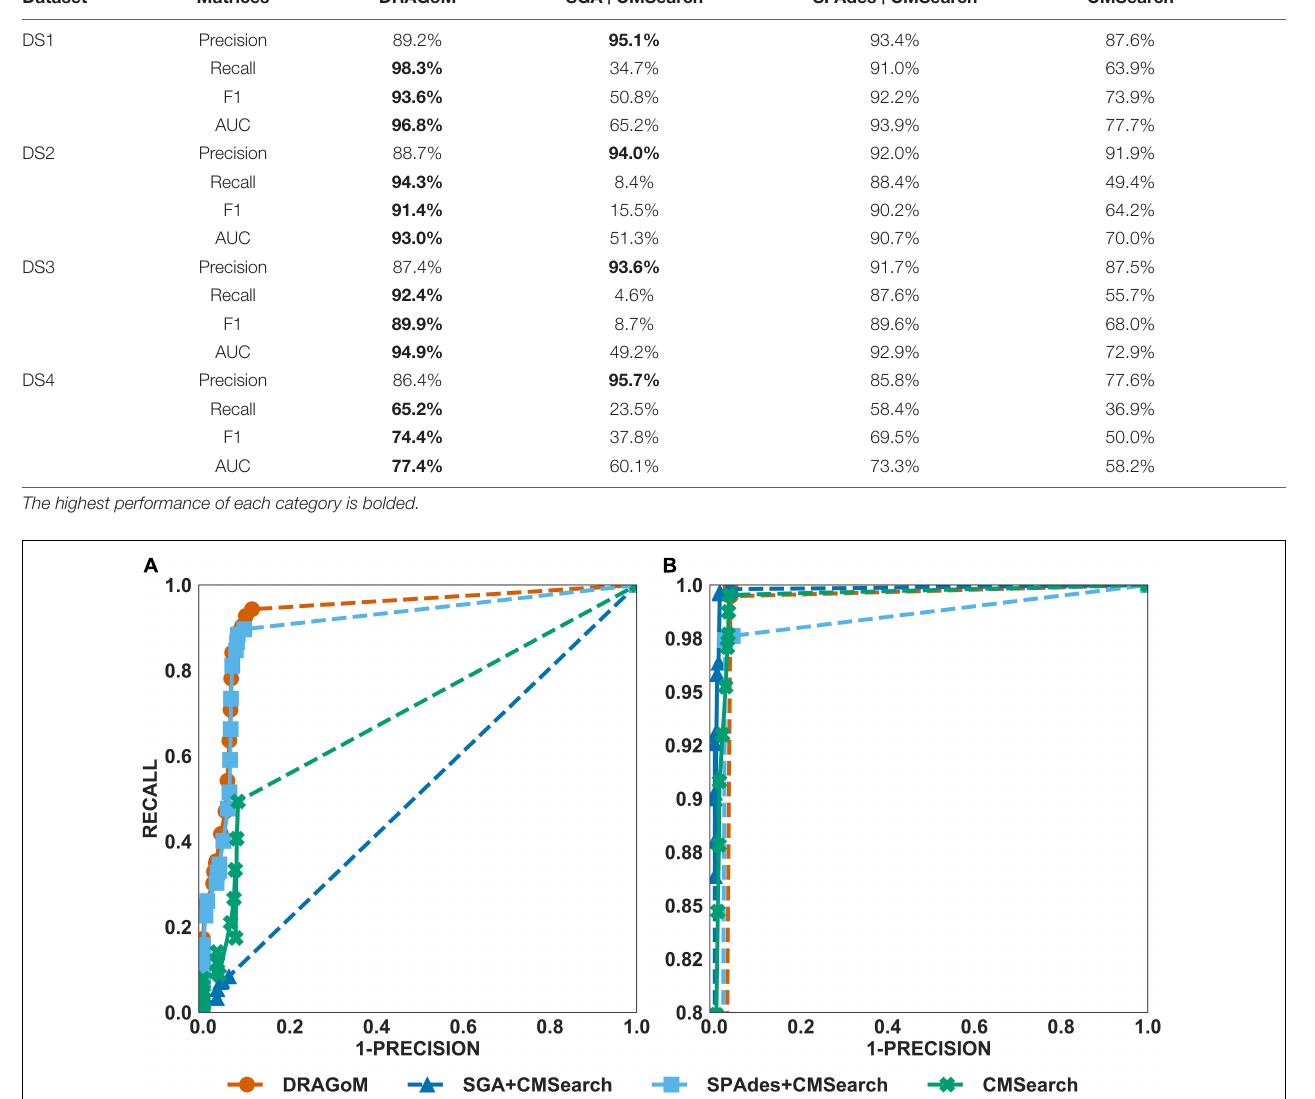
TABLE 2 | Performance summary of the tested methods on DS1–DS4 (for non-16S rRNA queries). Dataset